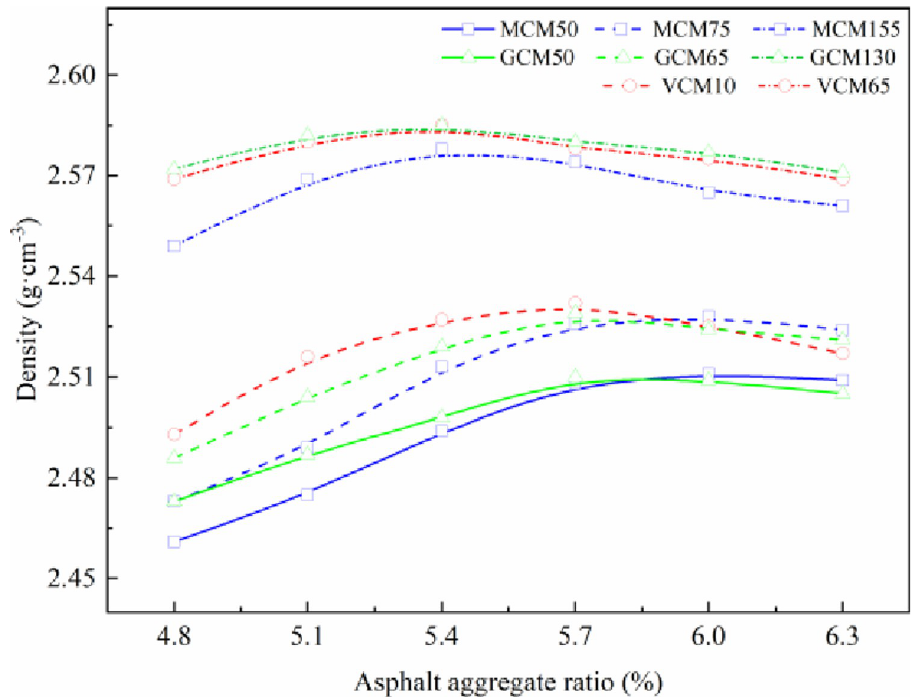
Fig 3. Relationship curve between specimen density and asphalt aggregate ratio.